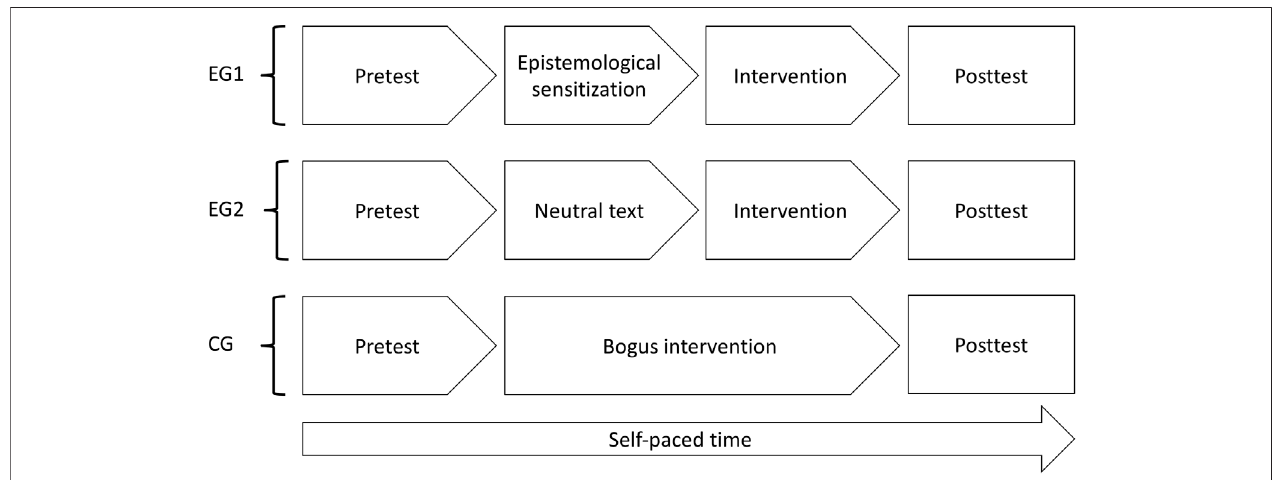
FIGURE 2 | Overview of the experimental condition and the